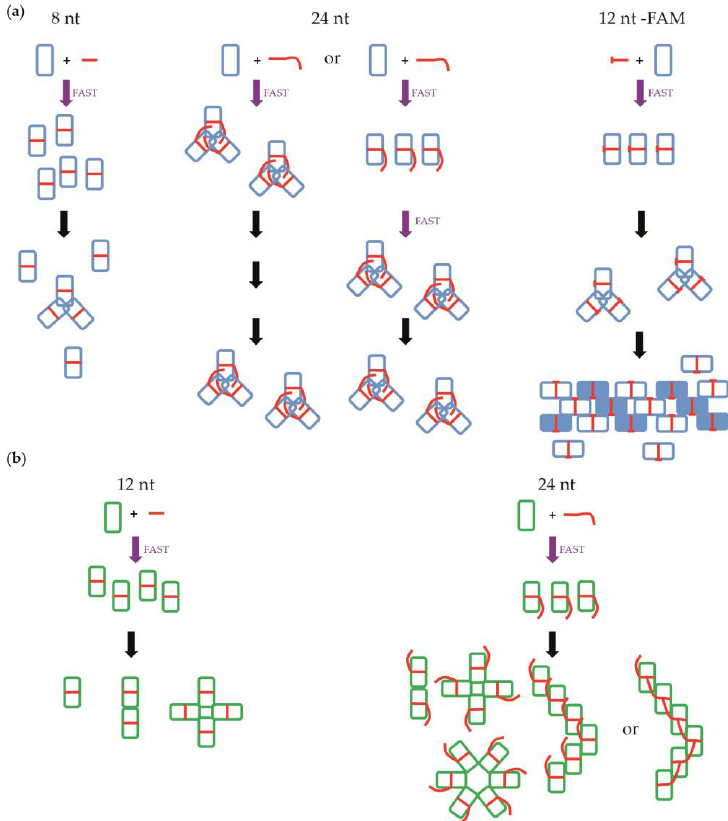
Figure 7. Schematic representation of the oligomerization of influenza A and B viruses’ nucleoproteins depending on the size of the RNA molecules at 150 mM NaCl. Panels ( a ) and ( b ) are for A/NP and B/NP,